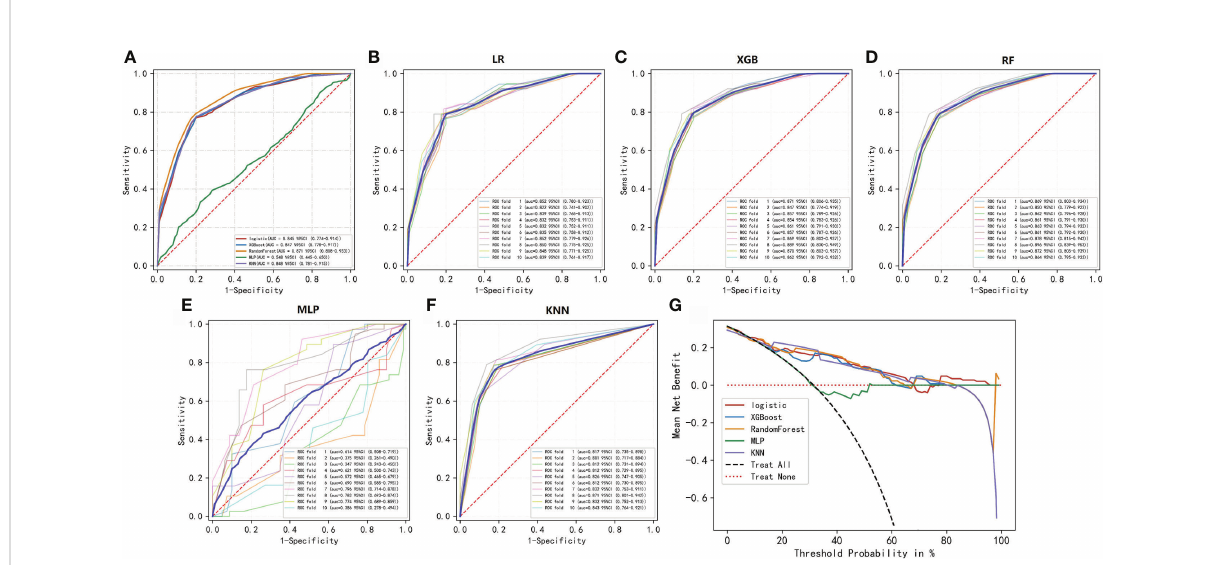
FIGURE 2 ROC and decision curve analyses of the fi ve ML algorithms. (A – F) ROC curve analysis of a ten-fold cross-validation of fi ve machine learning algorithms for predicting the risk of PCa in the training cohort. (G) Decision curve analysis demonstrating the net bene fi t associated with the use of the models for the prediction of upstaging.